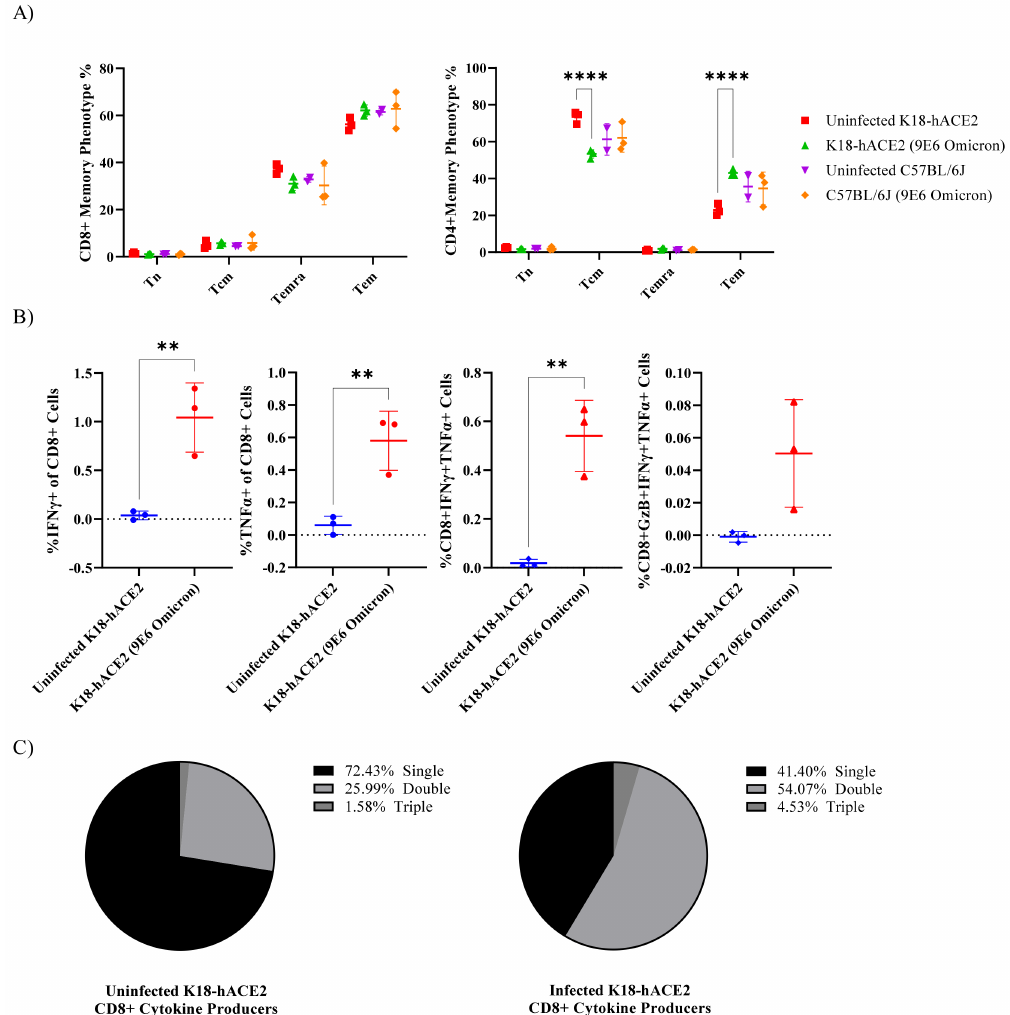
Figure 5. Omicron infection increases CD4+ Tem population and promotes cytokine production in CD8+ T cells in K18-hACE2 mice. ( A ) CD8+ and CD4+ memory phenotype was analyzed by gating naïve (Tn; CD45RA+ CCR7+), central memory (Tcm; CD45RA − CCR7+), effector memory (Tem; CD45RA − CCR7 − ), and terminally differentiated effector memory (Temra; CD45RA+ CCR7 − ) cells. ( B ) CD8+ T cells producing IFN-gamma, TNF-alpha, or Granzyme B by intracellular cytokine staining. ( C ) Multifunctional activity profiles of CD8+ T cells evaluated from IFN-gamma, TNF-alpha, and Granzyme B. Asterisks represent statistical significance by ANOVA test where (**) p ≤ 0.01; (****) p ≤ 0.0001; if (ns) p > 0.05 not